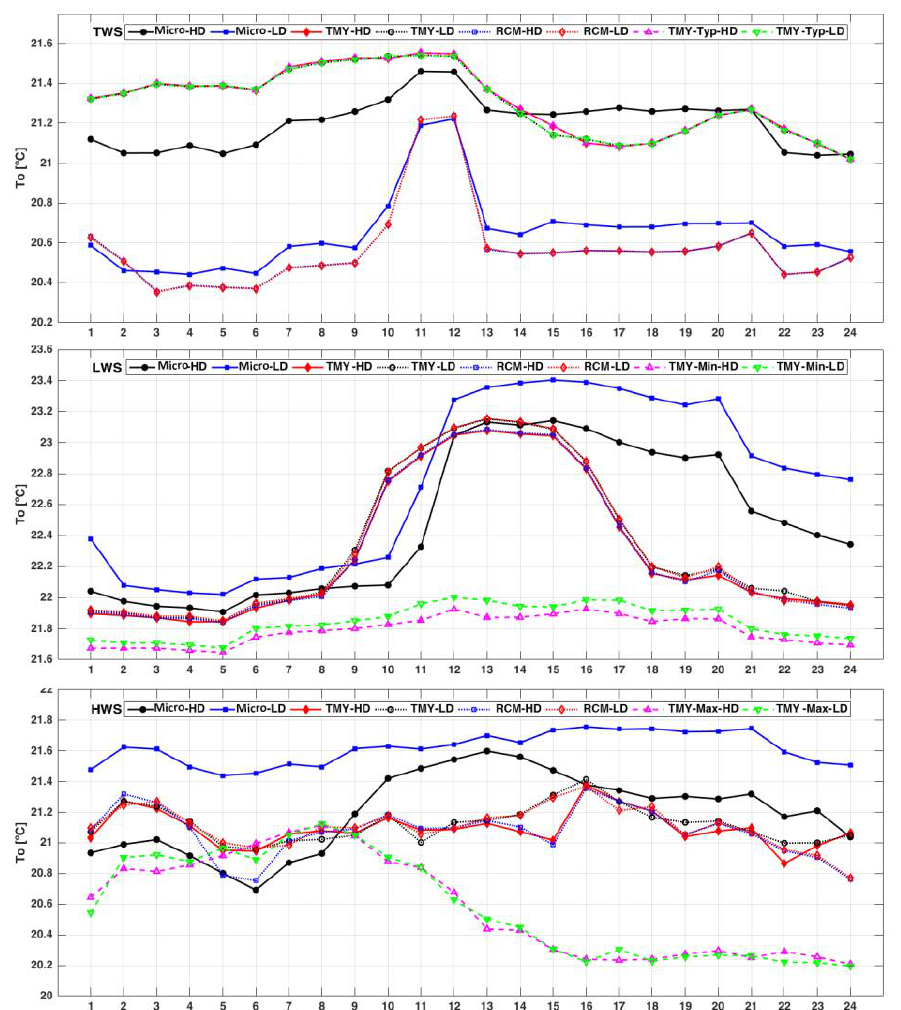
Figure 8. Hourly average T o of the central building in the LD and HD areas adopting fifteen weather datasets. TWS: 19 February; LWS: 4 October, HWS: 15 January; TMY-Typ: 14 September; TMY-Min: 17 November, and TMY-Max: 13 January. HD: High density; LD: Low density.